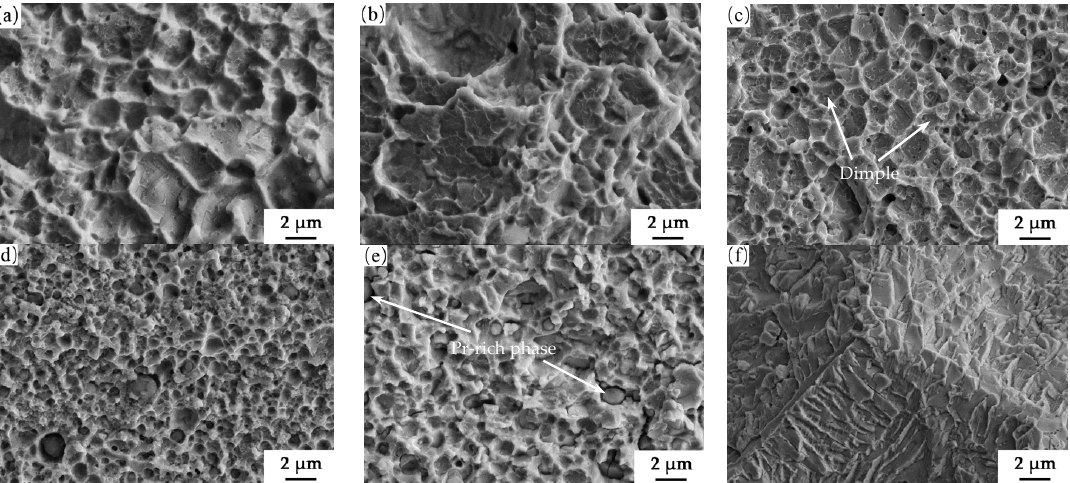
Figure 9. Shear strengths of the steel/steel lap joints using 12AgCuZnSn- x In- y Pr.